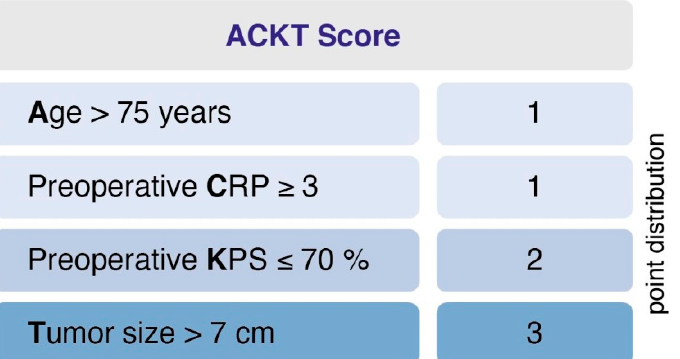
Figure 2. A clinical score to preoperatively estimate the risk of PMV occurrence in geriatric menin- gioma patients. An additive value of < 3 implies a probability of 98% for not developing postoper- ative PMV. PMV, prolonged mechanical